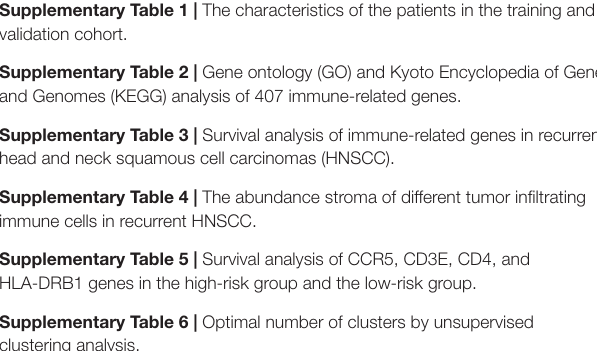
Supplementary Table 1 | The characteristics of the patients in the training and validation cohort.